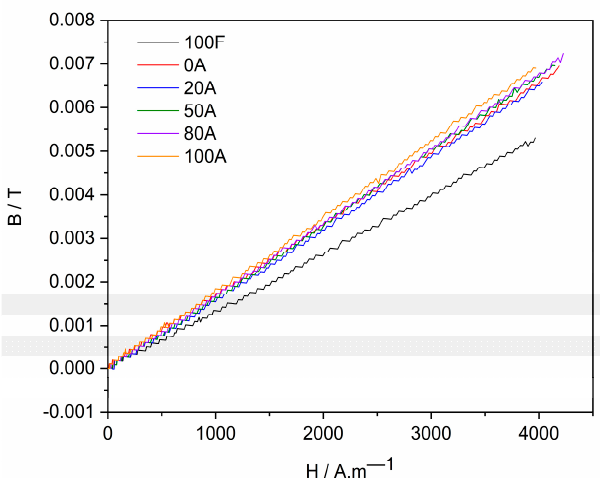
Figure 7. Resulting in magnetization characteristics of individual samples.